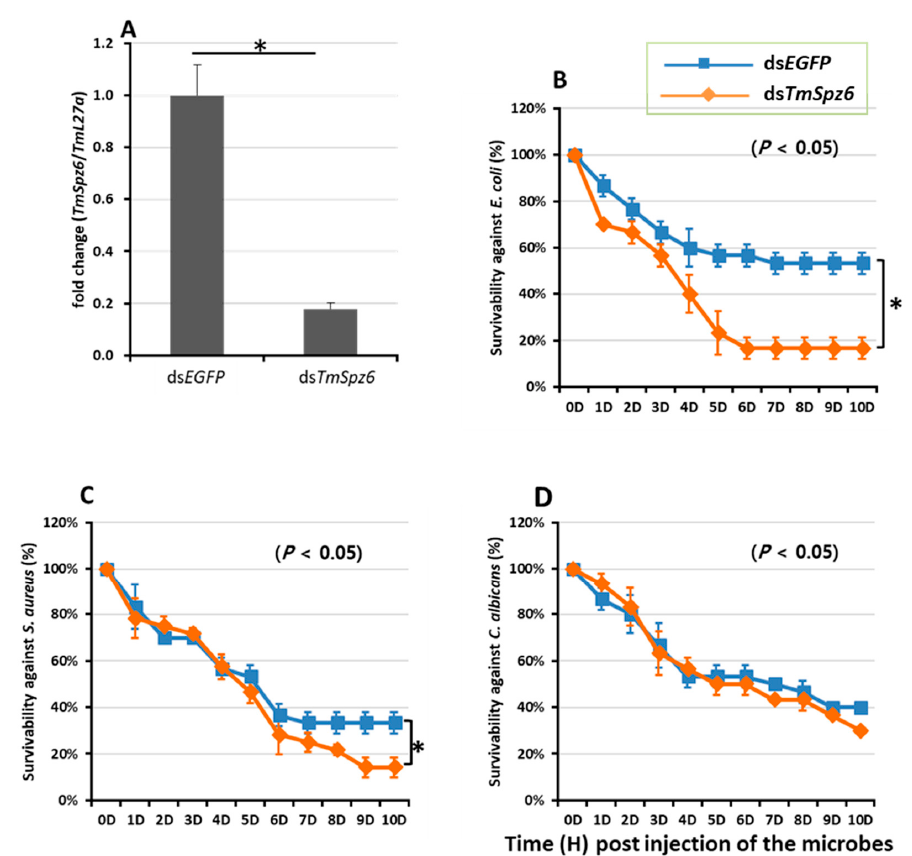
Figure 5. Effect of ds TmSpz6 on the survival of T. molitor larvae. Silencing efficiency of TmSpz6